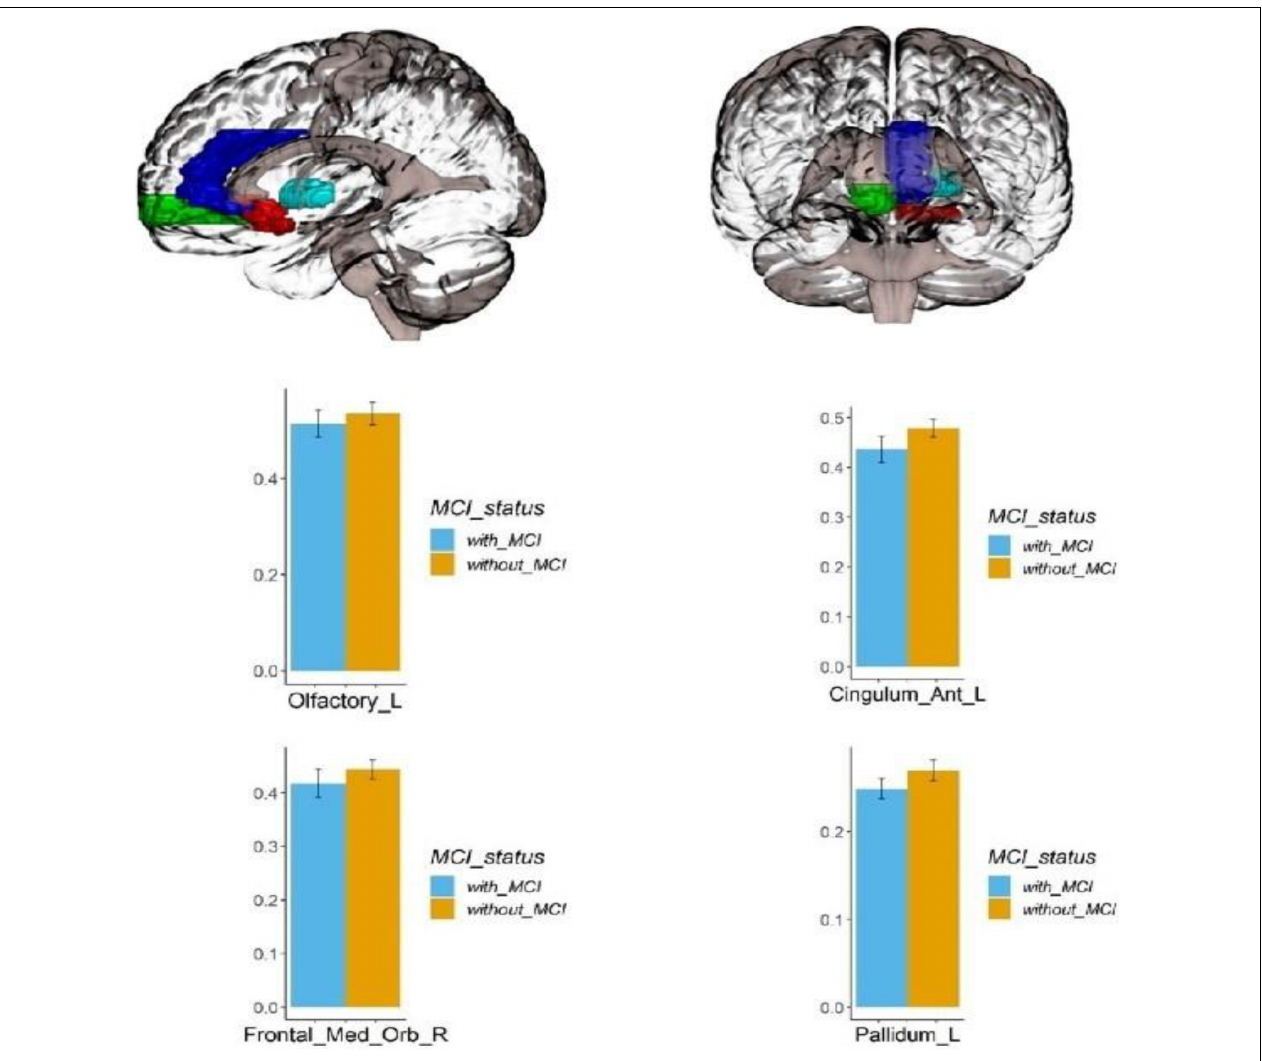
FIGURE 3 | Regional GM density comparison between the HA (with MCI) and LA (without MCI) groups. Left : The red area represents the left occipital lobe; The dark blue area represents the left cingulate gyrus; The green area represents the right orbital superior frontal gyrus; The light blue area represents the left globus pallidus; ( p < 0.05, Bonferroni corrected). Below right : bars represent statistical comparison of gray matter density in the left olfactory cortex, left cingulate gyrus, right orbital superior frontal gyrus and left globus pallidus between the HA and LA groups. L – left hemisphere, R – right